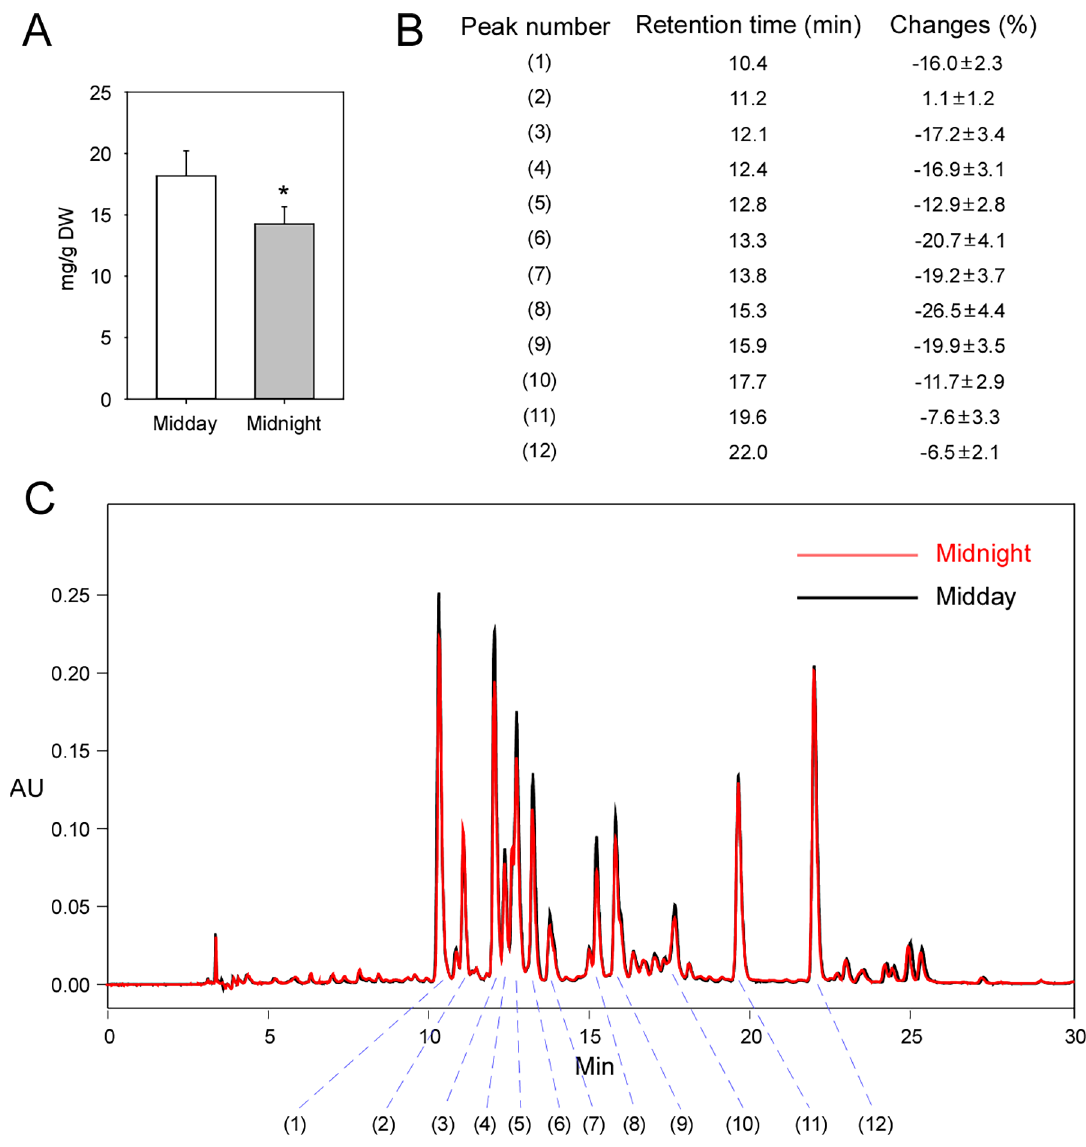
Fig 4. A comparison of the flavonoid contents between midday and midnight. (A) A comparison of the total flavonoid contents of Ginkgo leaves harvested at midday and midnight ( P < 0.01; Student’s t -test). (B) Changes in different flavonoid contents separated using the HPLC method. (C) Typical HPLC fingerprints (absorption at the 360-nm wavelength) of the total extract of Ginkgo leaves harvested at midday (black) and midnight (red). The main peaks are indicated by numbers. Asterisks indicate significant differences. Three independent replicates were performed for midday and midnight (mean ±